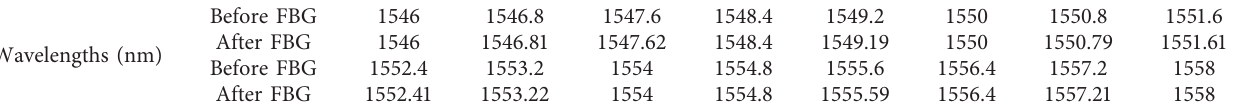
Table 3: Wavelengths corresponding to different values of reflectivity peaks before and after FBG.